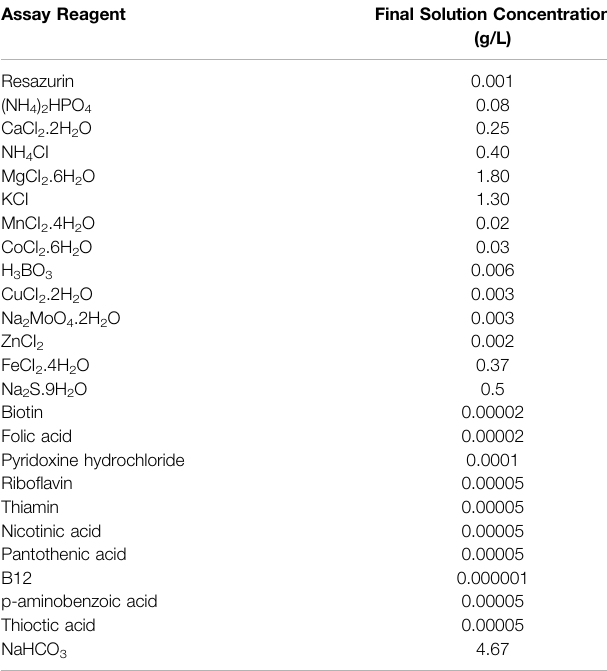
TABLE 1 | Nutrient concentration in biological methane potential (BMP) test solution prepared according to Owen et al. (1979). Assay Reagent Final Solution Concentration